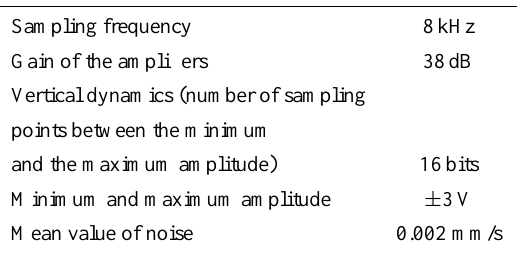
Table 1. Details of the acquisition system installed inside the